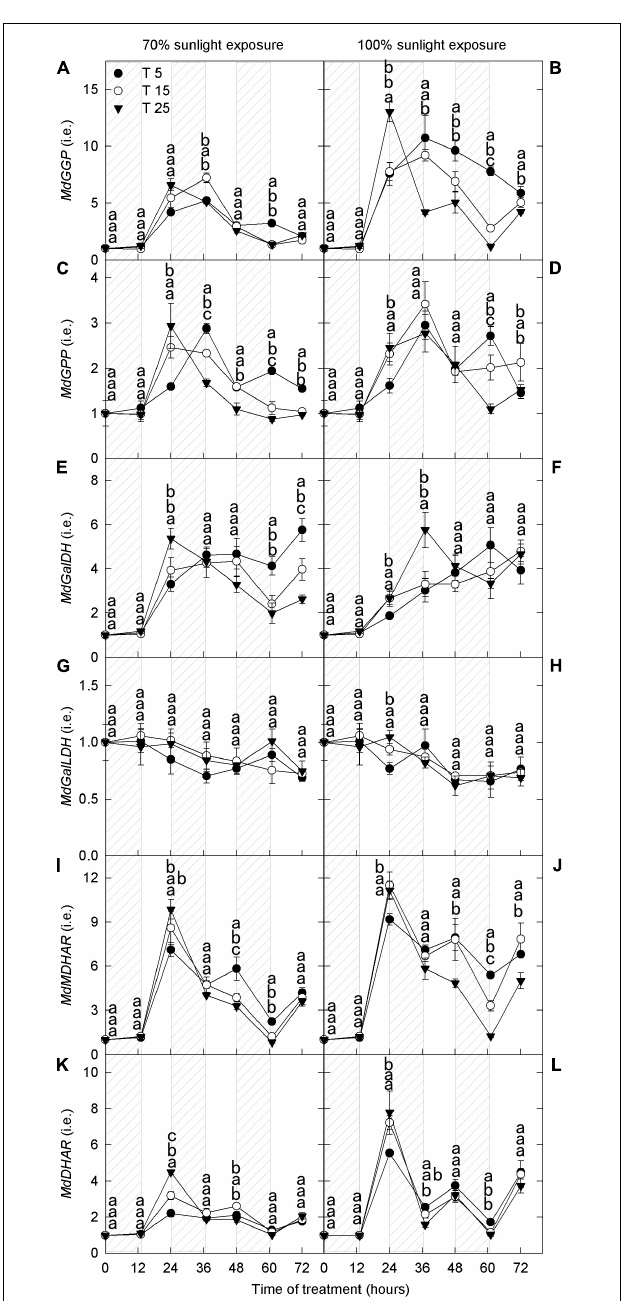
FIGURE 6 | Transcript levels of genes related to ascorbate metabolism in the peel of “Fuji” apple fruits exposed to different nighttime temperatures and sunlight intensities. Relative transcript level of MdGGP (A) , MdGPP (C) , MdGalDH (E) , MdGalLDH (G) , MdMDHAR (I) , and MdDHAR (K) in the peel of “Fuji” apples exposed to nighttime temperatures of 5, 15, and 25 ◦ C and 70% sunlight intensity. Relative transcript level of MdGGP (B) , MdGPP (D) , MdGalDH (F) , MdGalLDH (H) , MdMDHAR (J) , and MdDHAR (L) in the peel of “Fuji” apples exposed to nighttime temperatures of 5, 15, and 25 ◦ C and 100% sunlight intensity. GGP, GDP-L-galactose phosphorylase ; GPP, galactose-1-phosphatase ; GalDH, galactose dehydrogenase ; GalLDH, galactono lactone dehydrogenase ; MDHAR, monodehydroascorbate reductase ; and DHAR, dehydroascorbate reductase . Different lowercase letters indicate significant difference among treatments at P <